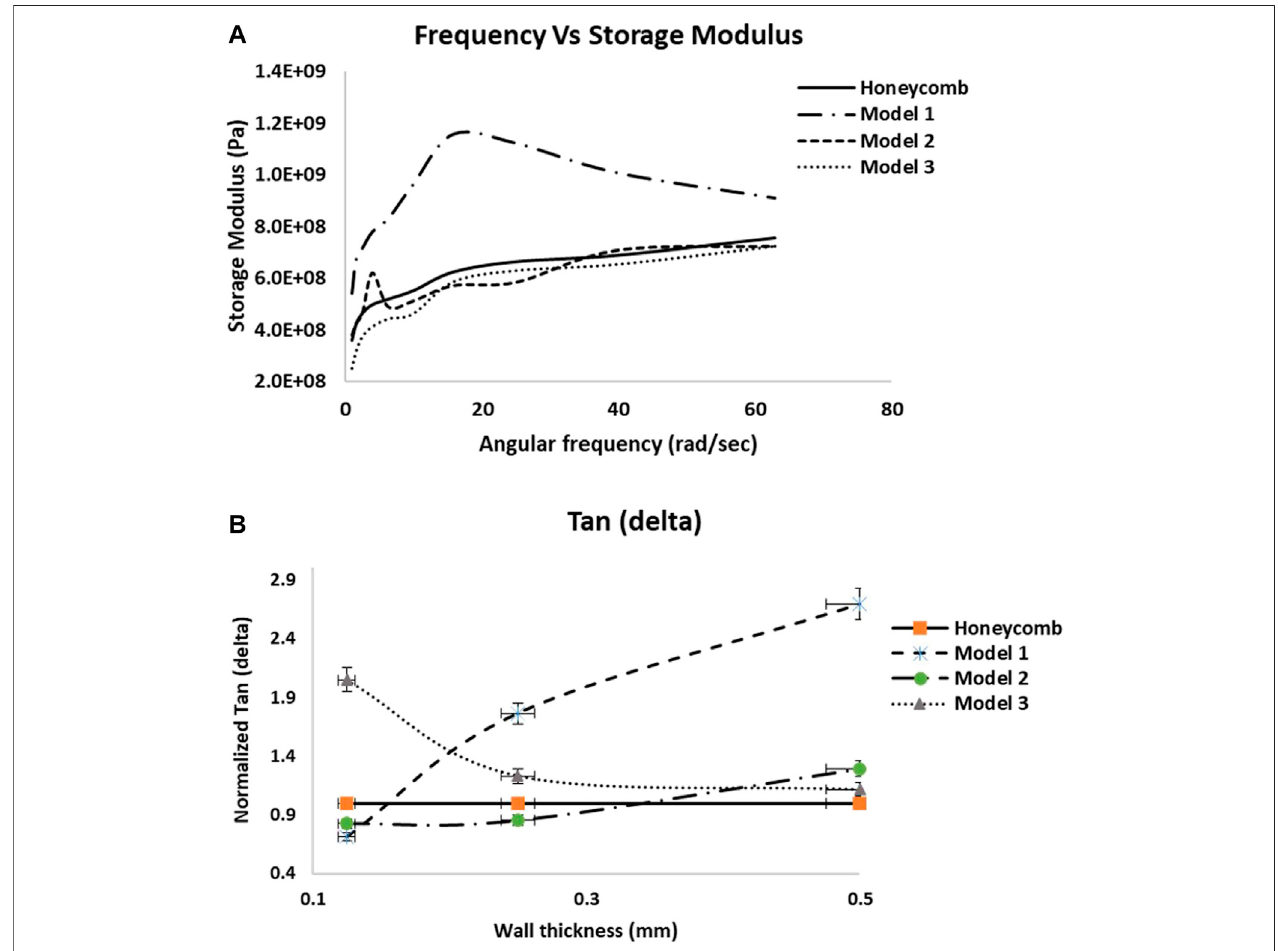
FIGURE 9 | (A) Storage modulus plotted with angular frequency, (B) Normalized Tan (delta) plotted with Wall thickness for different cellular structures.